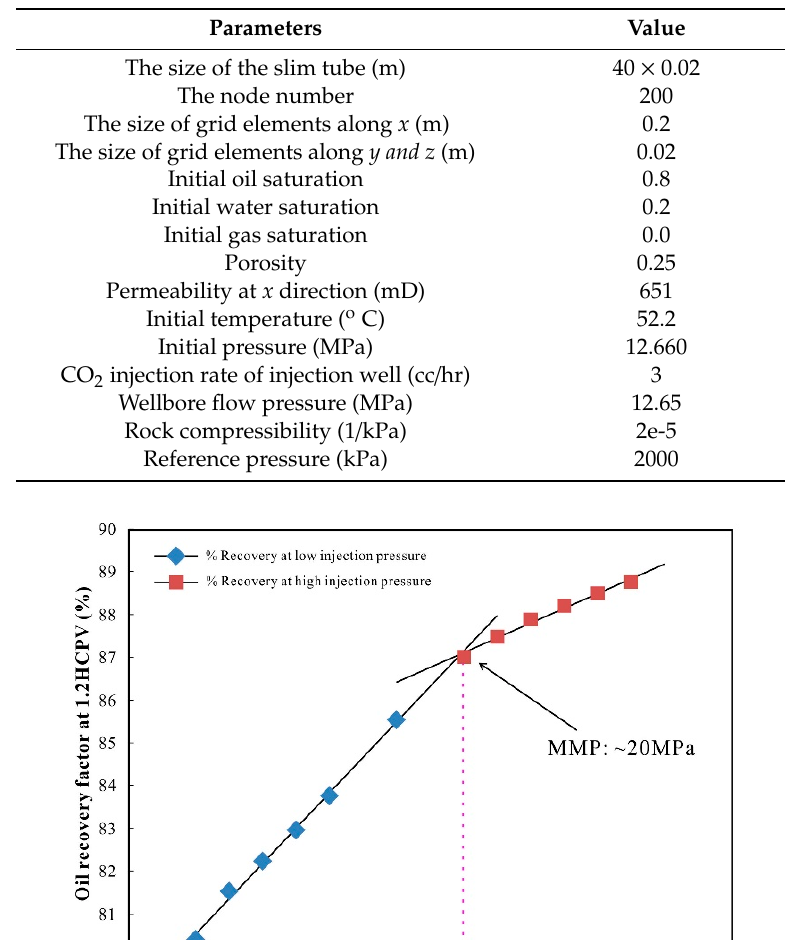
Main parameters used in 1-D slim tube flooding model (Reprint with permission